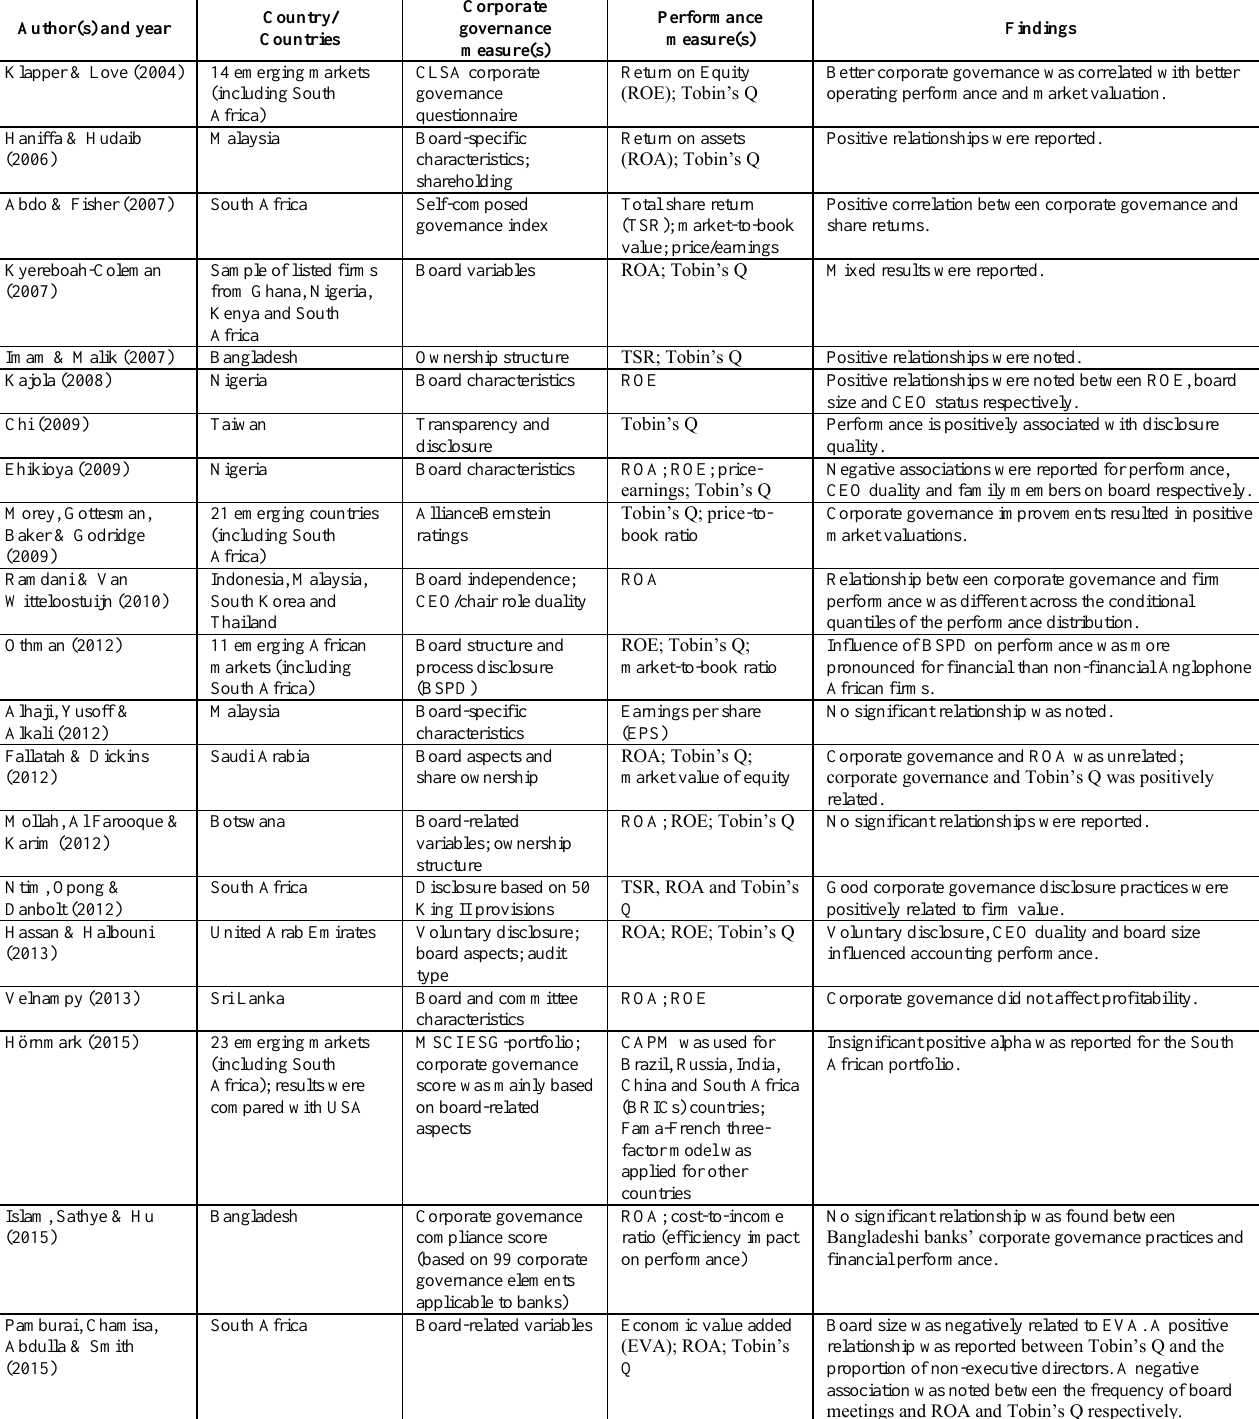
Table 1: Summary of corporate governance and financial performance